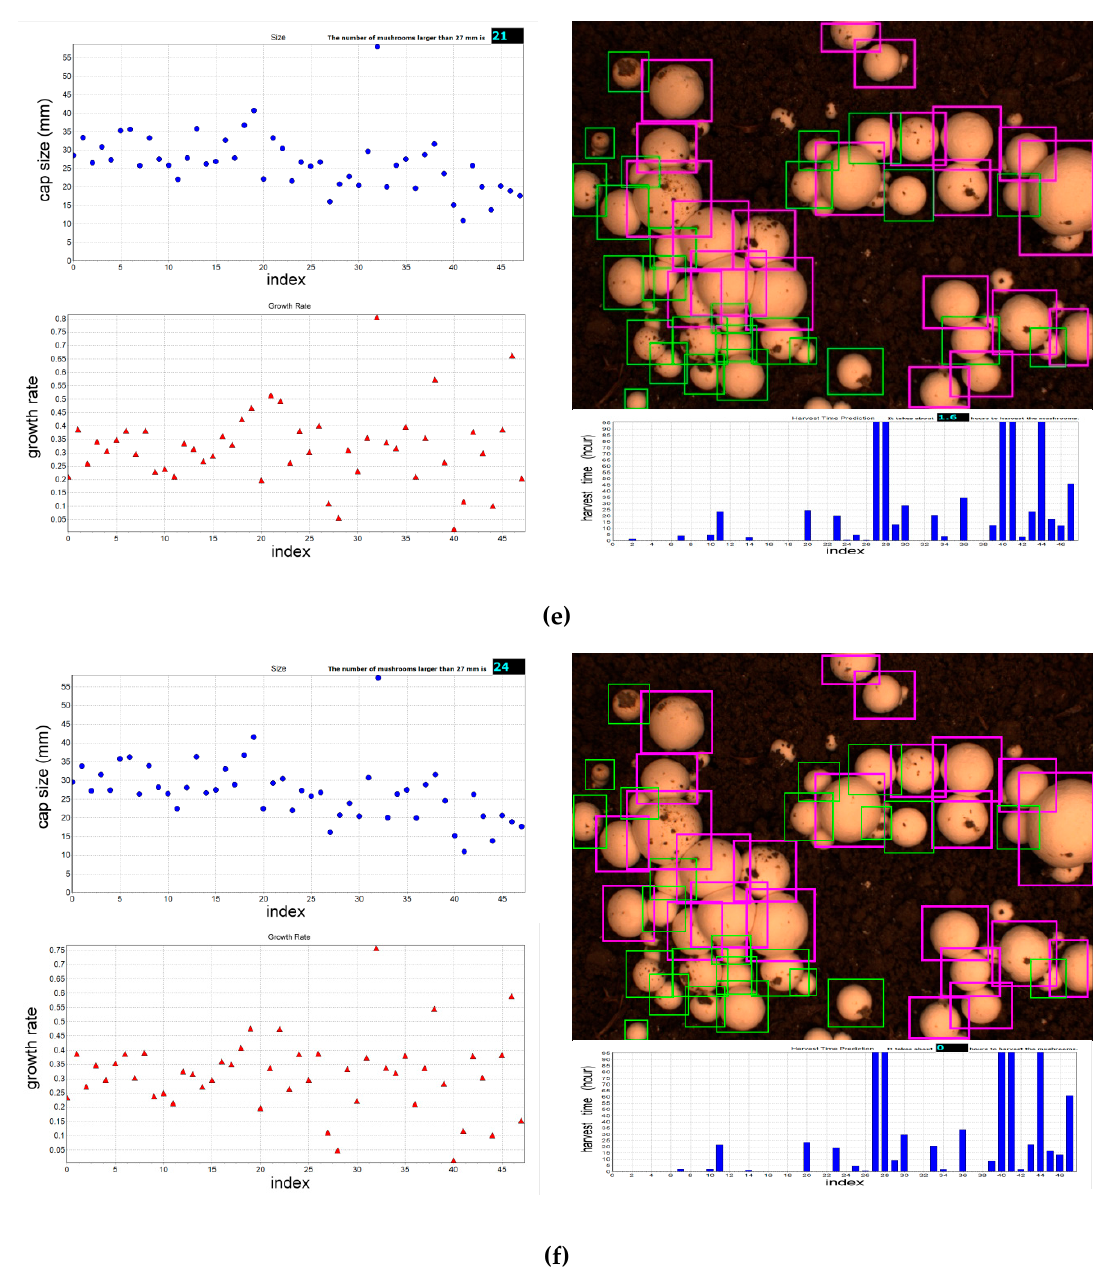
Figure 9. The measurement results at ( a ) the first time, ( b ) 7 h (7th), ( c ) 14 h (14th), ( d ) 21 h (21th), ( e ) 28 h (28th), and ( f ) 29 h (29th).